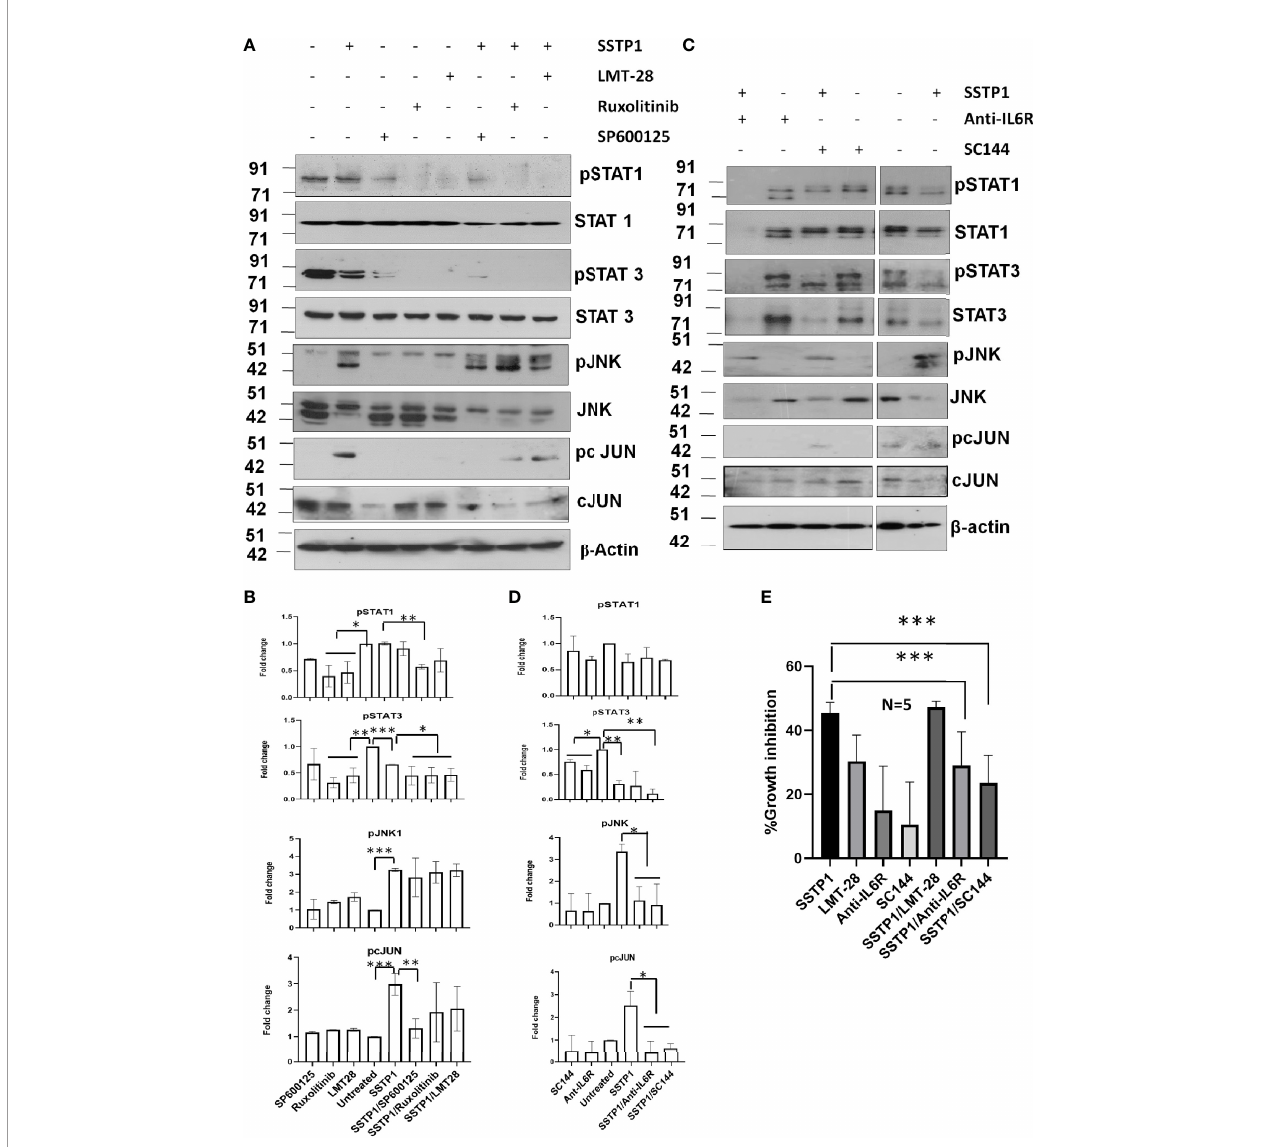
FIGURE 8 | SSTP1-induced pcJUN activation depends on JNK and on gp130 and IL6R a . (A) HSC-4 cells treated with SSTP1 (30 minute) and the indicated inhibitors were used for western blot analysis of the indicated molecules (B) Densitometric analysis was done for the bands of (a) and relative phosphorylation based on untreated is plotted. (C) The cells treated with SSTP1 (30 minutes) and IL6R a antibody or SC144 were used for western blot analysis of the indicated molecules. (D) Densitometric analysis was done for the bands of (C) and relative phosphorylation based on untreated is plotted. (E) Growth inhibition analyzed by MTT assay after 4h treatment with SSTP1(10 m M) with or without the inhibitors. LMT-28 (60 m M). For all the experiments SSTP1 (10 m M) was used with or without LMT-28 (60 m M), Ruxolitinib (30 m M) or SP600125 (20 m M), Anti-IL6R a (10µg/ml) or SC144 (40 m M). Cells were pre-treated with the inhibitors LMT-28 (1.5 h), Ruxolitinib (1.5h) or SP600125 (1h), Anti-IL6R a (2h) or SC144 (2h) prior to the addition of SSTP1. *p < .05, **p < .01, ***p <